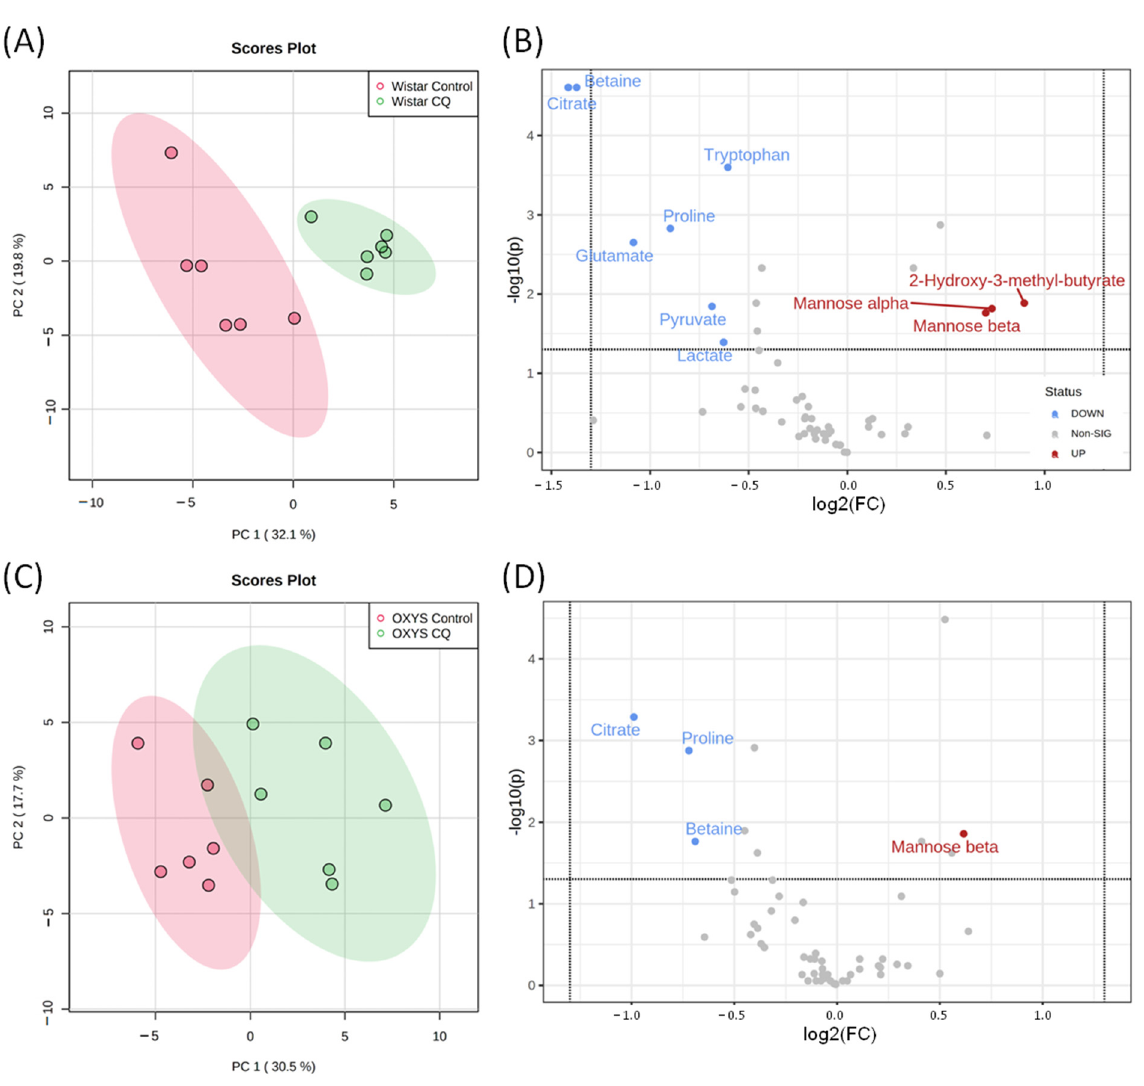
Figure 6. The metabolomic profiles of control and CQ treatment groups. PCA score plots and Volcano plots of blood metabolites of Wistar ( A , B ) and OXYS ( C , D ) rat strains. In Volcano plots, horizontal line depicts a cut-off of FDR-adjusted p -value = 0.05, metabolites with fold change threshold (CQ treatment vs. control) = 1.5 are highlighted.